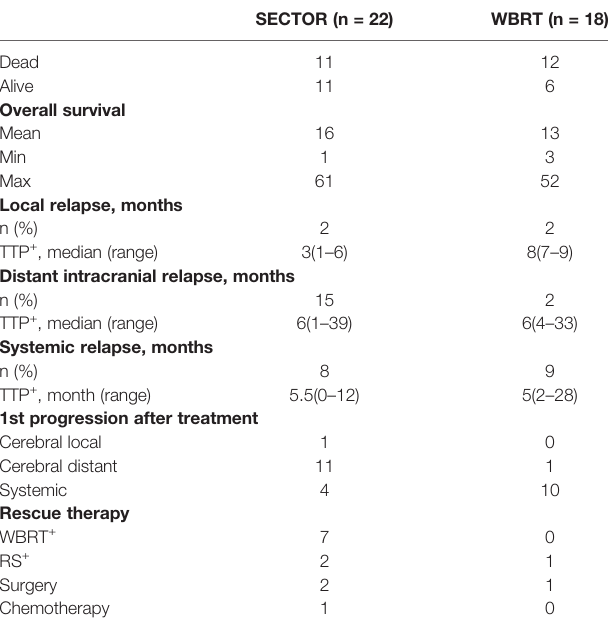
TABLE 2 | Outcome